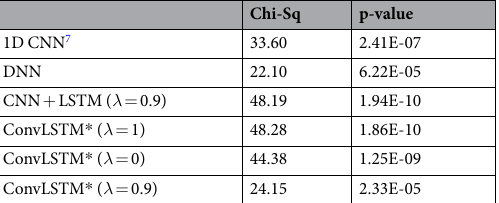
Table 4. Results of the log-rank test applied on the normalized biological age acceleration η = ( CA − BA )/ CA using the estimated biological ages.